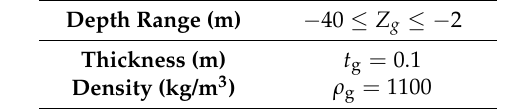
Table 4. Simulation Results Comparison: Growth Mass and Flooded Legs Mass.